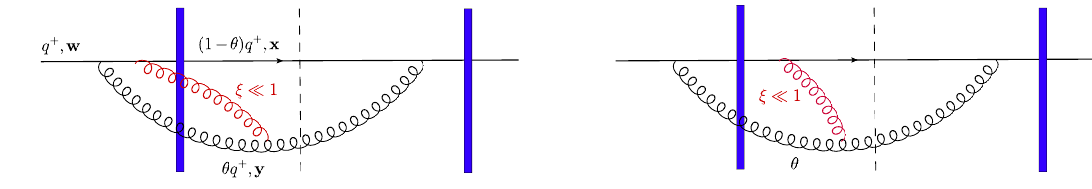
Figure 20 . Graphs representing virtual corrections to the qg dijet cross-section. Both shown graphs count for the BK evolution of the dipole S ( x , y ) which enters the second term in the r.h.s. of eq.